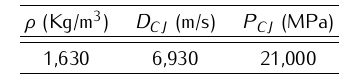
Table 5. Explosion characteristics of TNT.